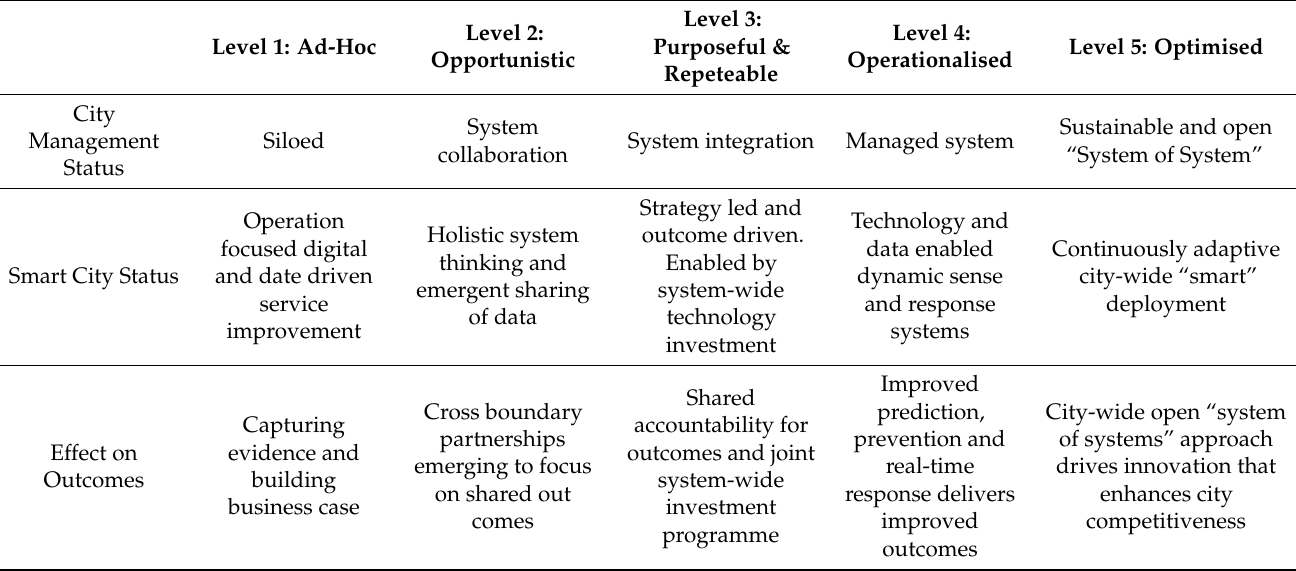
Table 3. IDC maturity levels.